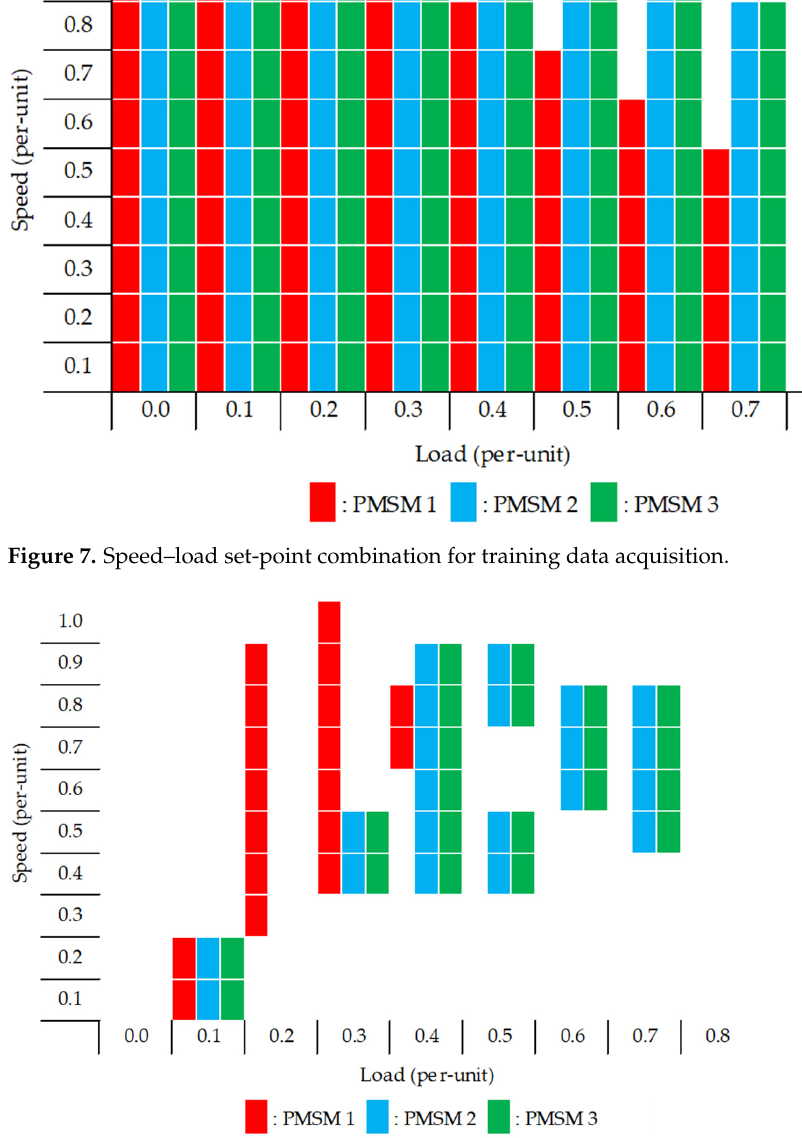
Figure 8. Speed–load set-point combination for validating data acquisition.